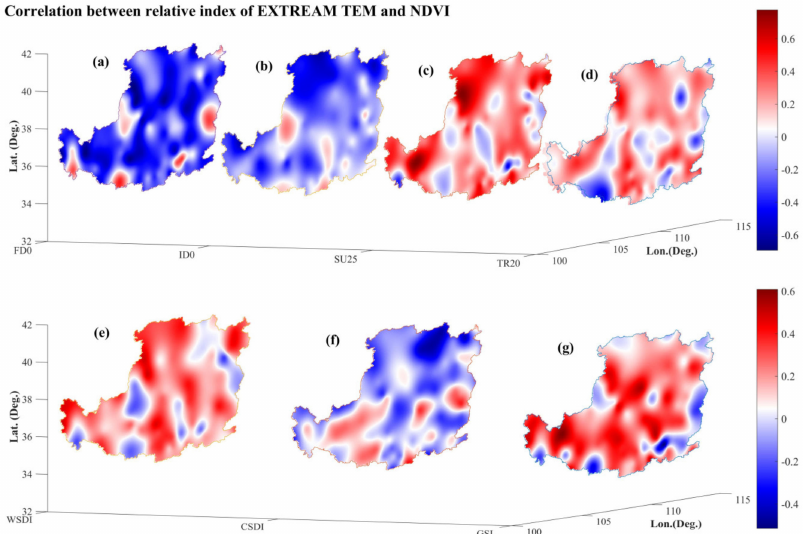
Figure 14. Distribution of Pearson correlation coe ffi cients of NDVI with extreme climatic indices in the Loess Plateau region, the extreme climatic indices are ( a ) FD0, ( b ) ID0, ( c ) SU25, ( d ) TR20. ( e ) WSDI, ( f ) CSDI. ( g ) GSL.